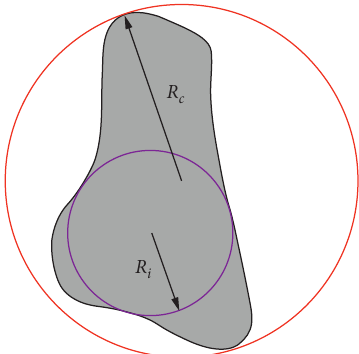
Figure 6: Geometric parameters used in the definition of sphericity ( S